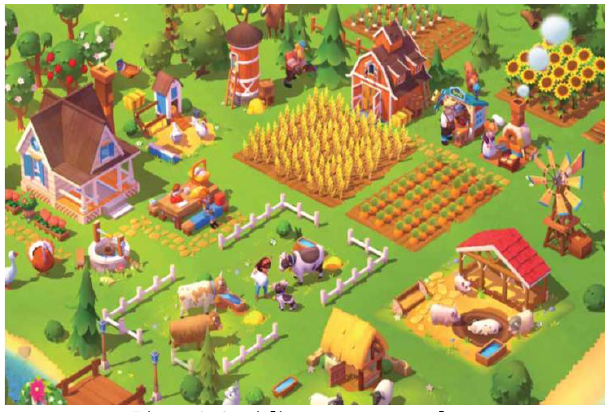
Figure 6: Socializers game